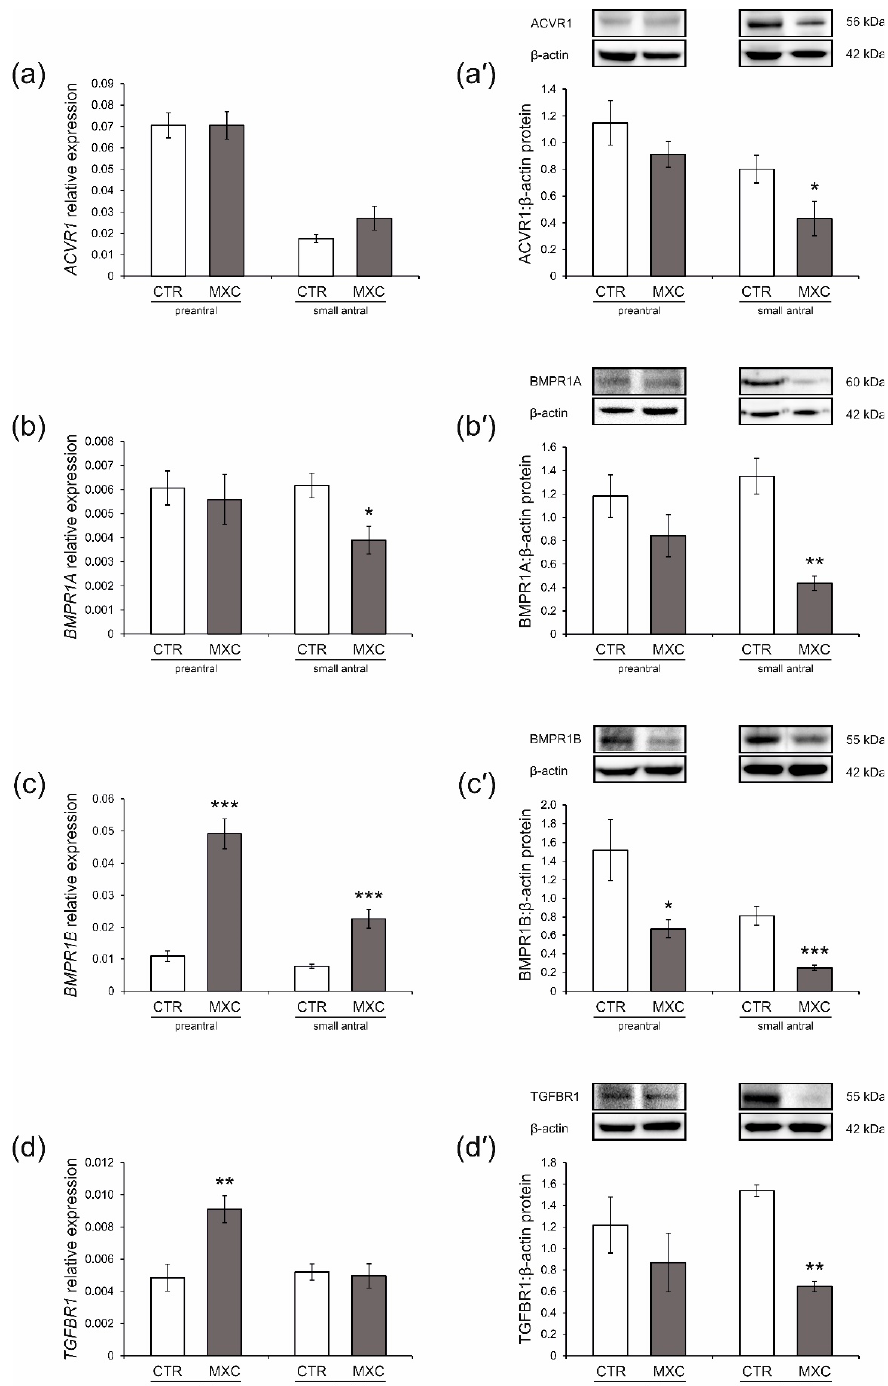
Figure 2. ACVR1 ( a , a’ ), BMPR1A ( b , b’ ), BMPR1B ( c , c’ ), and TGFBR1 ( d , d’ ) mRNA and protein abundance in preantral (primordial, primary, and secondary follicles) and small antral follicles obtained from the control (CTR) and methoxychlor (MXC-) treated gilts. The mRNA expression (quantitative real-time PCR) is presented relative to GAPDH as mean ± SEM ( a – d ). Relative protein abundance was measured by the densitometric method and expressed as the ratio relative to β -actin abundance (mean ± SEM, a’ – d’ ). The fragment of membranes with bands corresponding to predicted molecular weights is shown above graphs. Asterisks denote significant differences between the CTR and treated animals (for preantral follicles pool n = 5, for small antral follicle n = 15, * p < 0.05, ** p < 0.01, *** p < 0.001, Mann–Whitney U